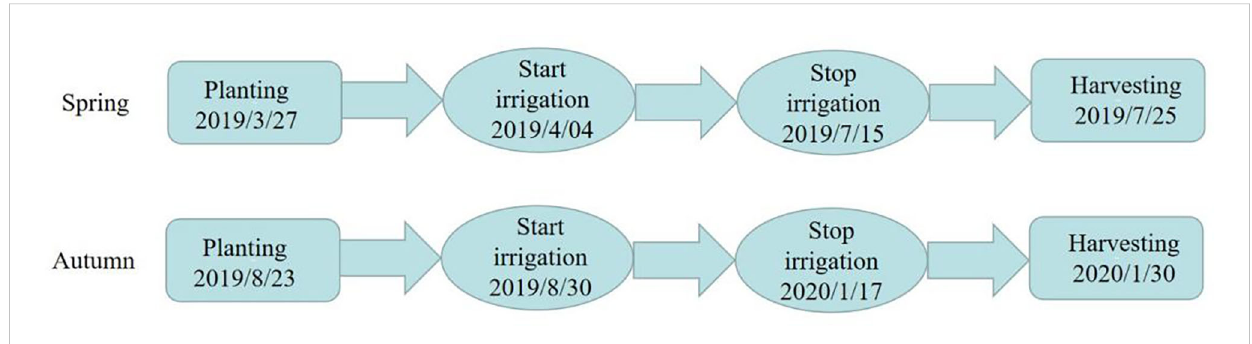
FIGURE 1 The planting, irrigation and harvesting time of